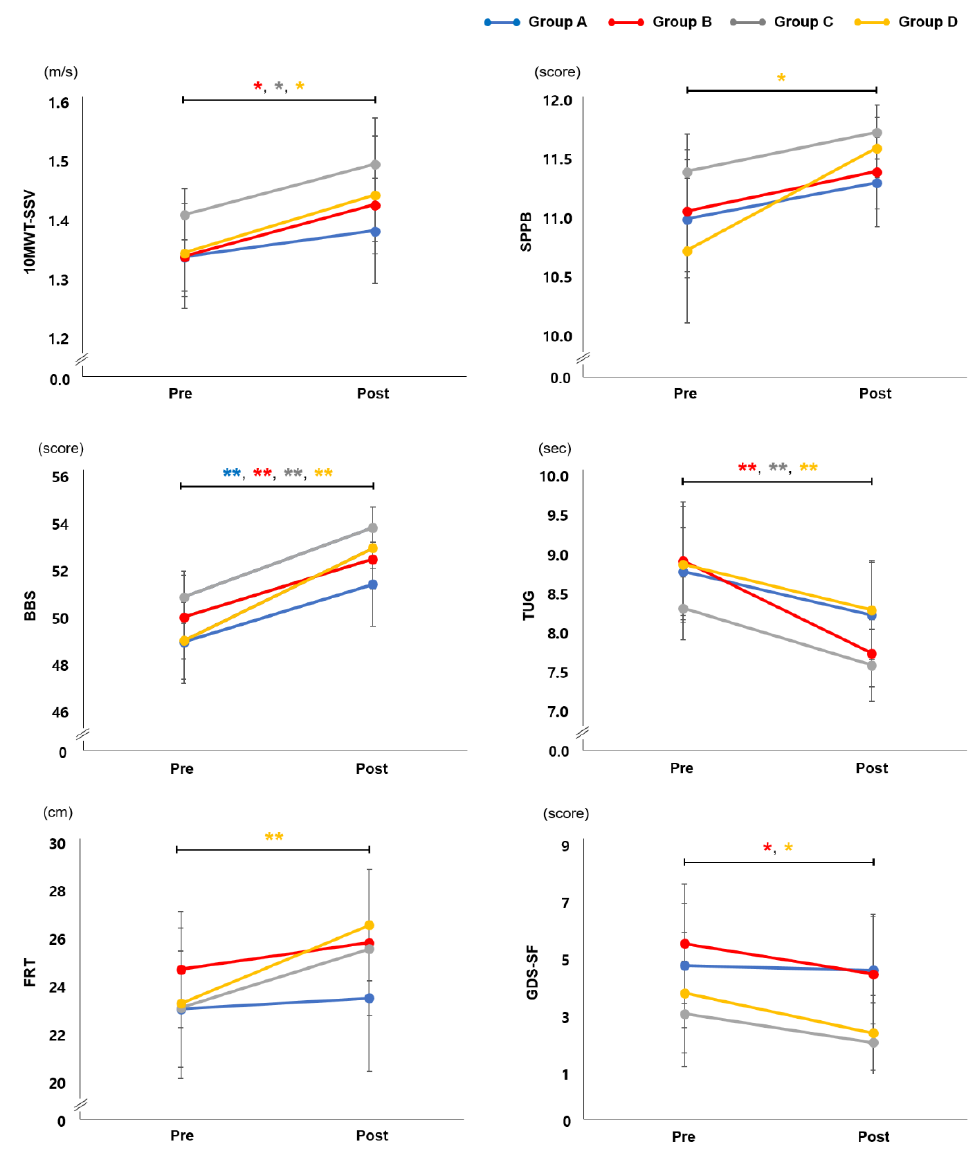
Figure 2. Physical Function. Changes in physical function at the pre and post time points in groups A, B, C, and D. Group A: overground walking without an EX1, group B: overground walking using the resistance mode of EX1, group C: stair ascent using the assistance mode of EX1, group D: inclined treadmill walking using the assistance mode of EX1. Paired t -tests were used for 10MWT-SSV, TUG, and FRT and Wilcoxon signed-rank tests for SPPB, BBS, and GDS-SF. * p < 0.05 compared with pre, ** p < 0.01 compared with pre. 10MWT-SSV, 10-Meter Walk Test for self-selected velocity; BBS, Berg Balance Scale; FRT, Functional Reach Test; GDS-SF, Geriatric Depression Scale—Short Form; SPPB, Short Physical Performance Battery; TUG, Timed Up and Go.